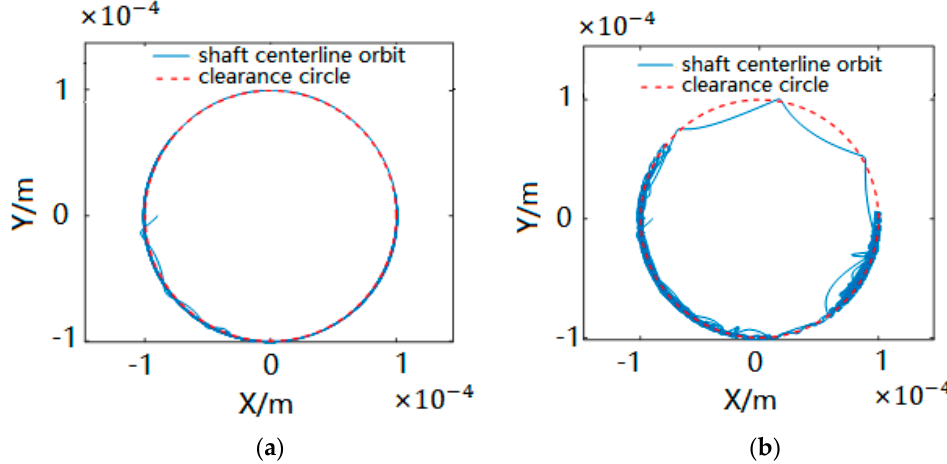
Figure 12. Shaft centerline orbit: ( a ) the constant coefficient of restitution model, ( b ) the new coefficient of restitution model.